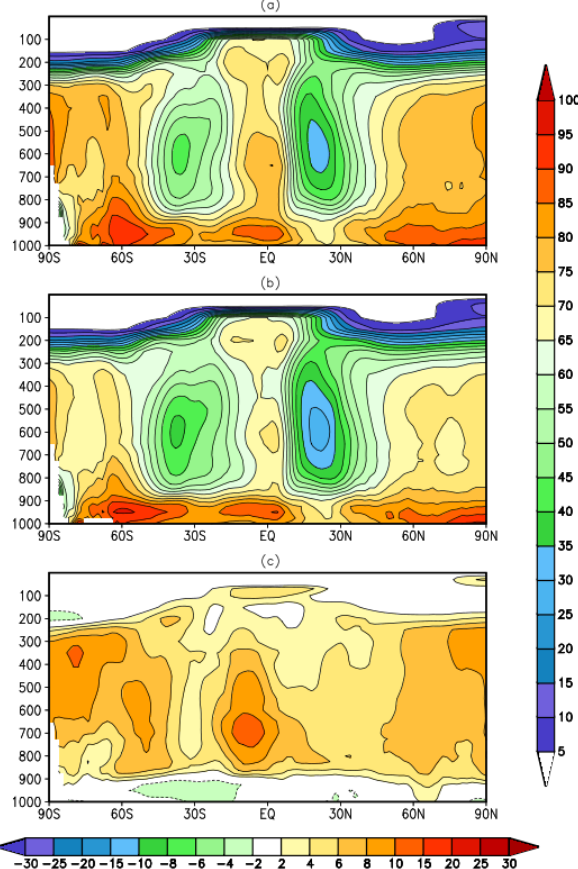
Figure 9. December-January-February-averaged cloud fraction from (a) experiment 5 (MERRA AGCM-like), (b) experiment 4 (MERRA2 AGCM-like) and (c) AIRS retrievals.